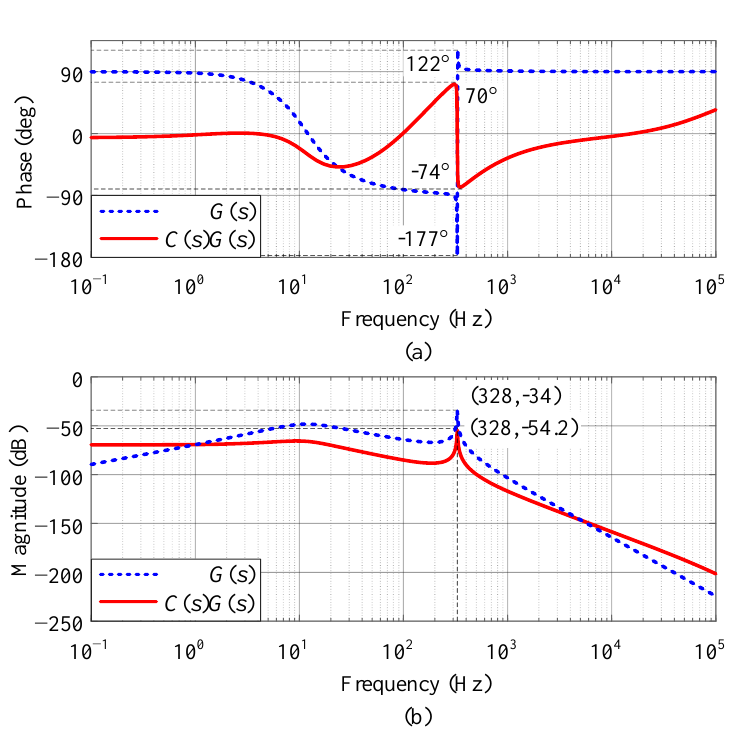
Figure 8. Frequency response curves: ( a ) phase response; ( b ) magnitude